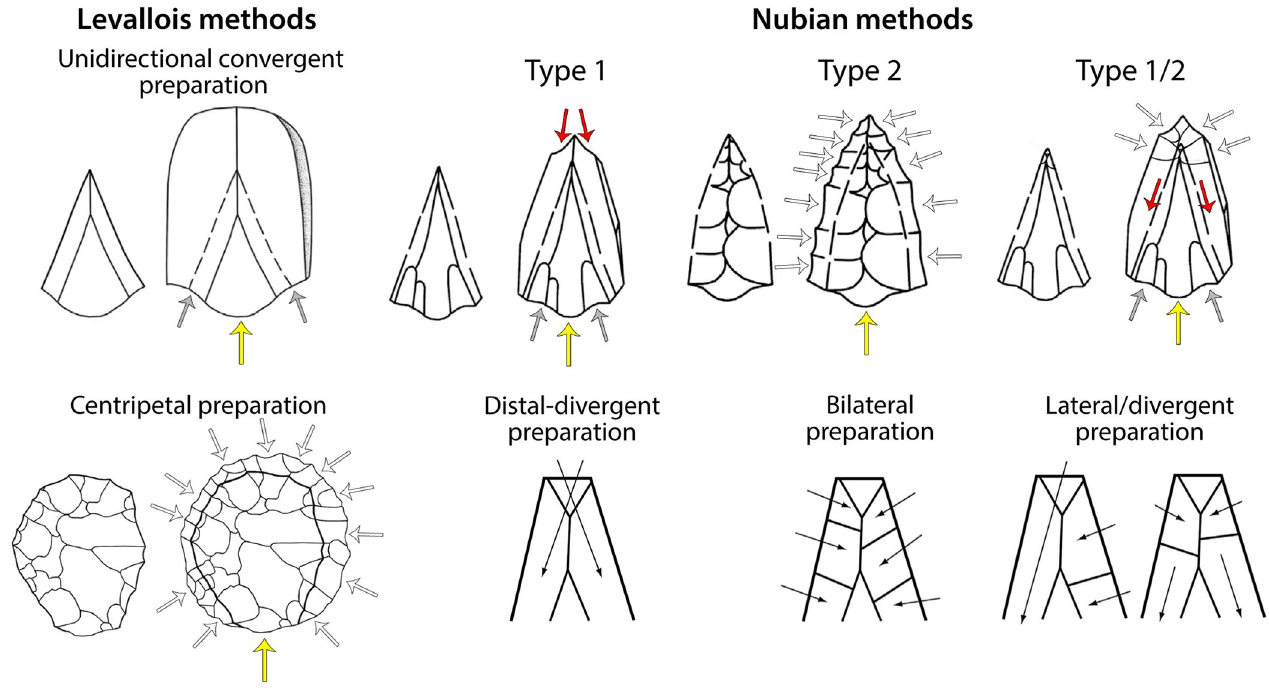
Fig 2. Schematic of Levallois and Nubian production methods (modified from [28, 29]).